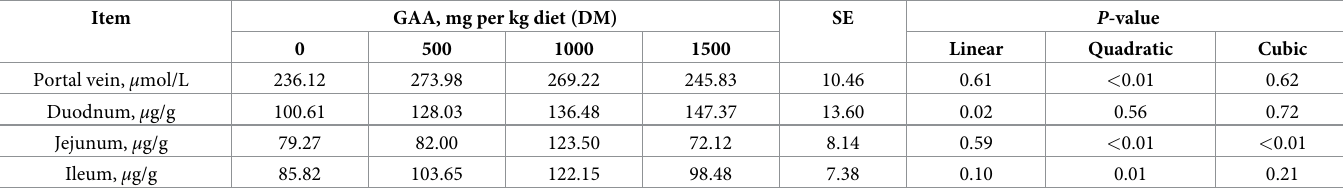
Table 7. GAA concentration in portal plasma and in small intestinal segment mucosa of lambs after feeding 4 h. Item GAA, mg per kg diet (DM) SE P -value 0 500 1000 1500 Linear Quadratic Cubic Portal vein, μ mol/L 236.12 273.98 269.22 245.83 10.46 0.61 0.62 Duodnum, μ g/g 100.61 Jejunum, μ g/g Ileum, μ g/g The results were presented as least squares means and standard error (SE), with P < 0.05 indicating the effects are significant. n = 6 lambs/group.